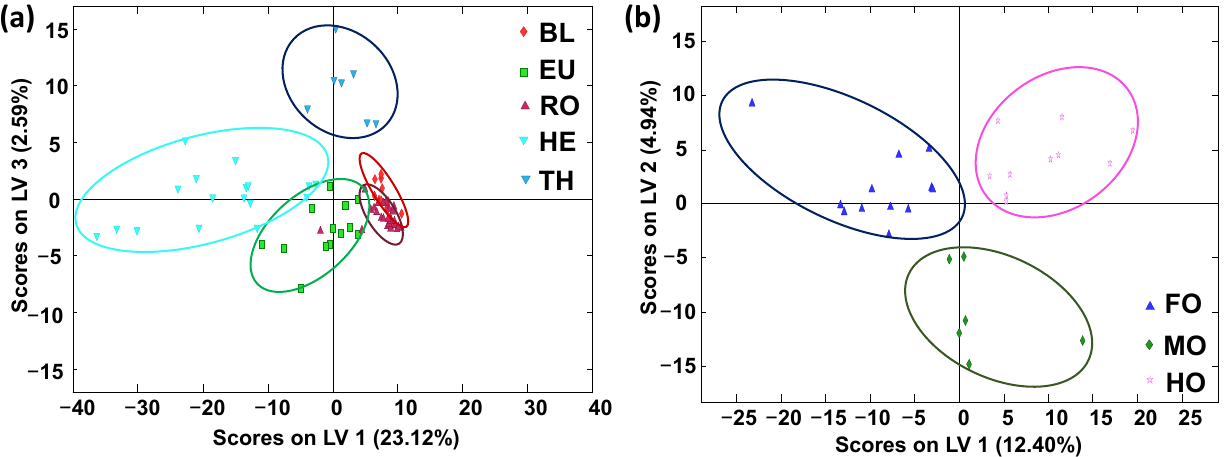
Figure 4. PLS–DA score plots when using non-targeted LC–HRMS fingerprints as honey chemical descriptors for ( a ) blossom honey botanical variety classification (LV1 vs. LV3 score plot, three LVs were used to build the model) and ( b ) honeydew honey botanical variety classification (LV1 vs. LV2 score plot, three LVs were used to build the model). BL: orange/lemon blossom; EU: eucalyptus; FO: forest; HE: heather; HO: holm oak; MO: mountain; RO: rosemary; TH: thyme. Table 1. Multiclass predictions by cross-validation for the set of blossom-honey samples using three LVs. BL: orange/lemon blossom; RO: rosemary; EU: eucalyptus; TH: thyme, and HE: heather. Sample Class Variety Sensitivity (%)